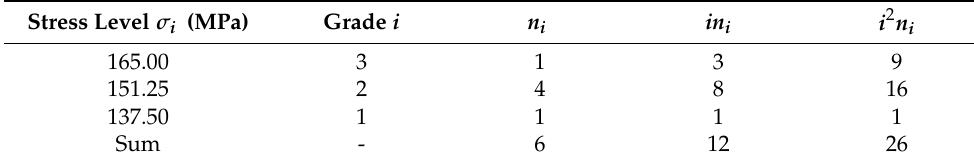
Table 7. Statistical results of the non-failure